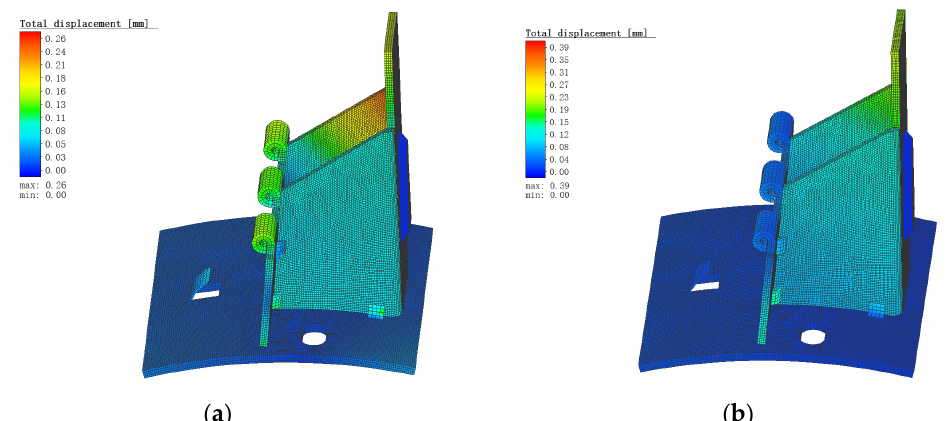
Figure 9. Total displacement diagram at the welding speed of 4 mm/s and 10 mm/s; ( a ) 4 mm/s; ( b ) 10 mm/s.